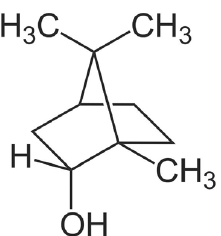
FIGURE 1 - Chemical structure of borneol (monoterpene, bicyclic aromatic